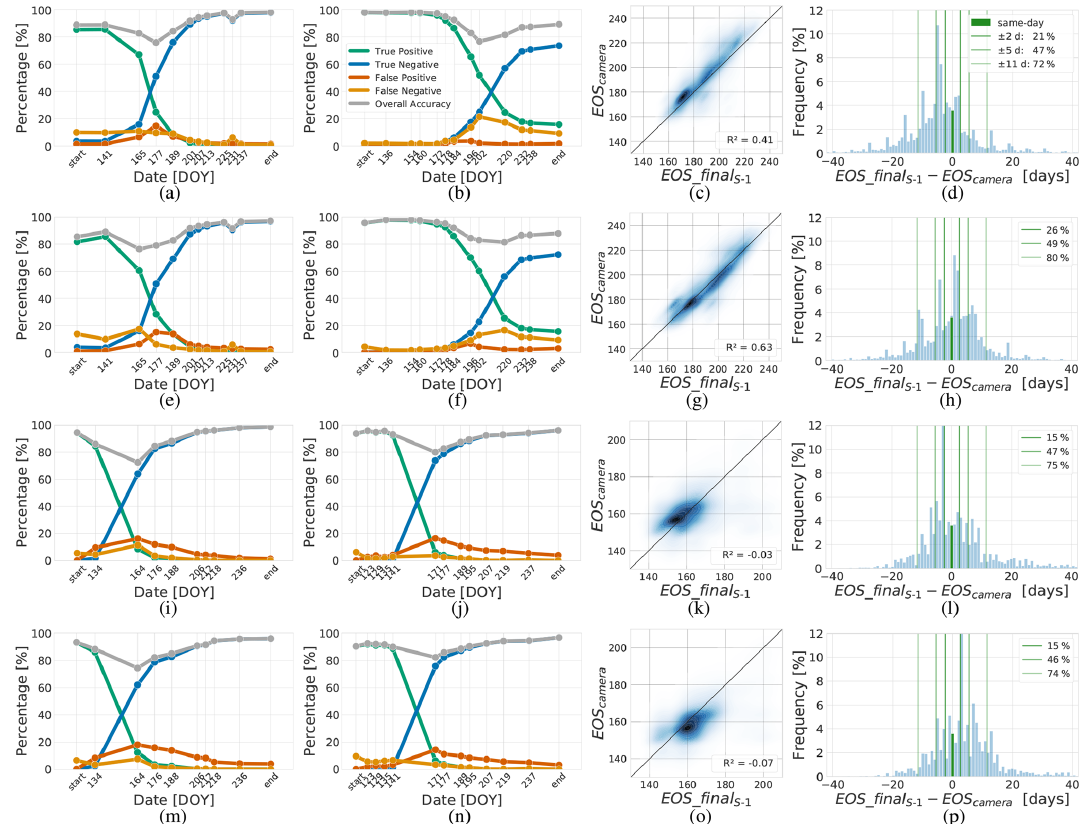
Figure 13. (a, b) Seasonal development of true positive, false positive, true negative, and false negative as well as overall accuracy of the snow cover maps of the year (a) 2017 and (b) 2018. Overall accuracy is always above 75% and in more than half of the cases above 90%. Generally, false negative responses or underestimation of snow cover is dominant. False positive responses or overestimation occurs mostly in 2017 around DOY 177. (c) Correlation between EOS detection from S-1 time series approach and time-lapse imagery. (d) Distribution of temporal offsets in EOS. Highlighted are used time ranges corresponding to 0.5, 1 and 2 Sentinel-1 revisits. (a–d) ZRA 4dB threshold. (e–h) ZRA derivative. (i–l) KRA 4dB threshold. (m–p) KRA